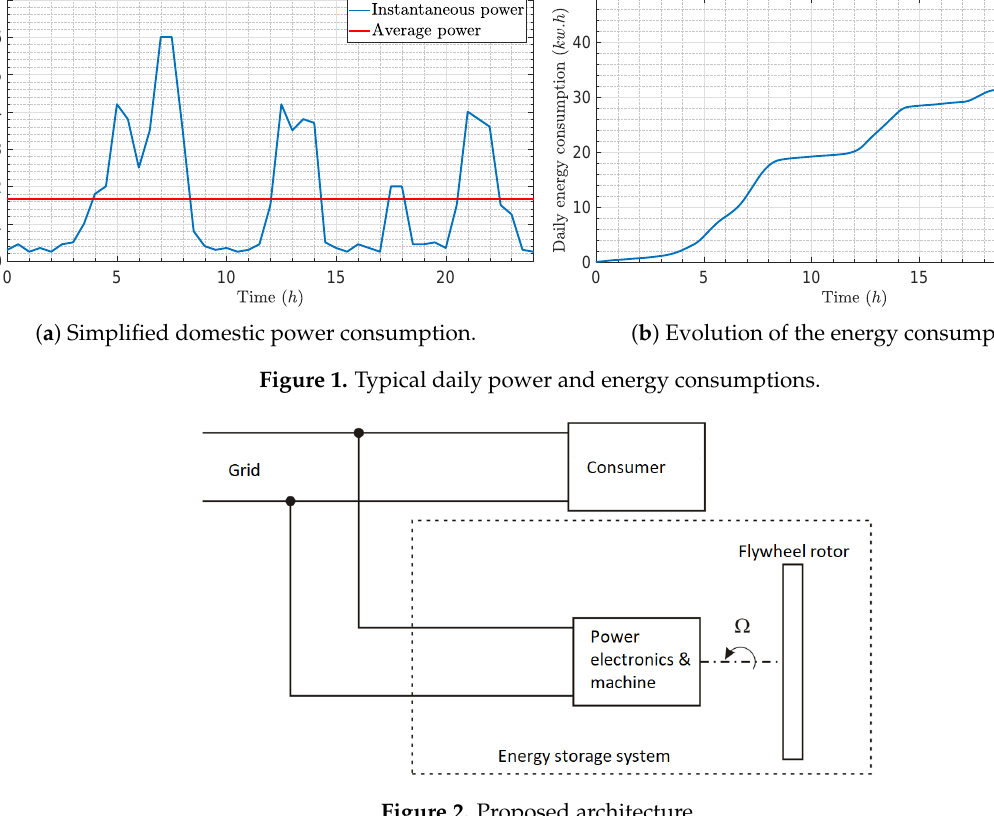
Figure 2. Proposed architecture.